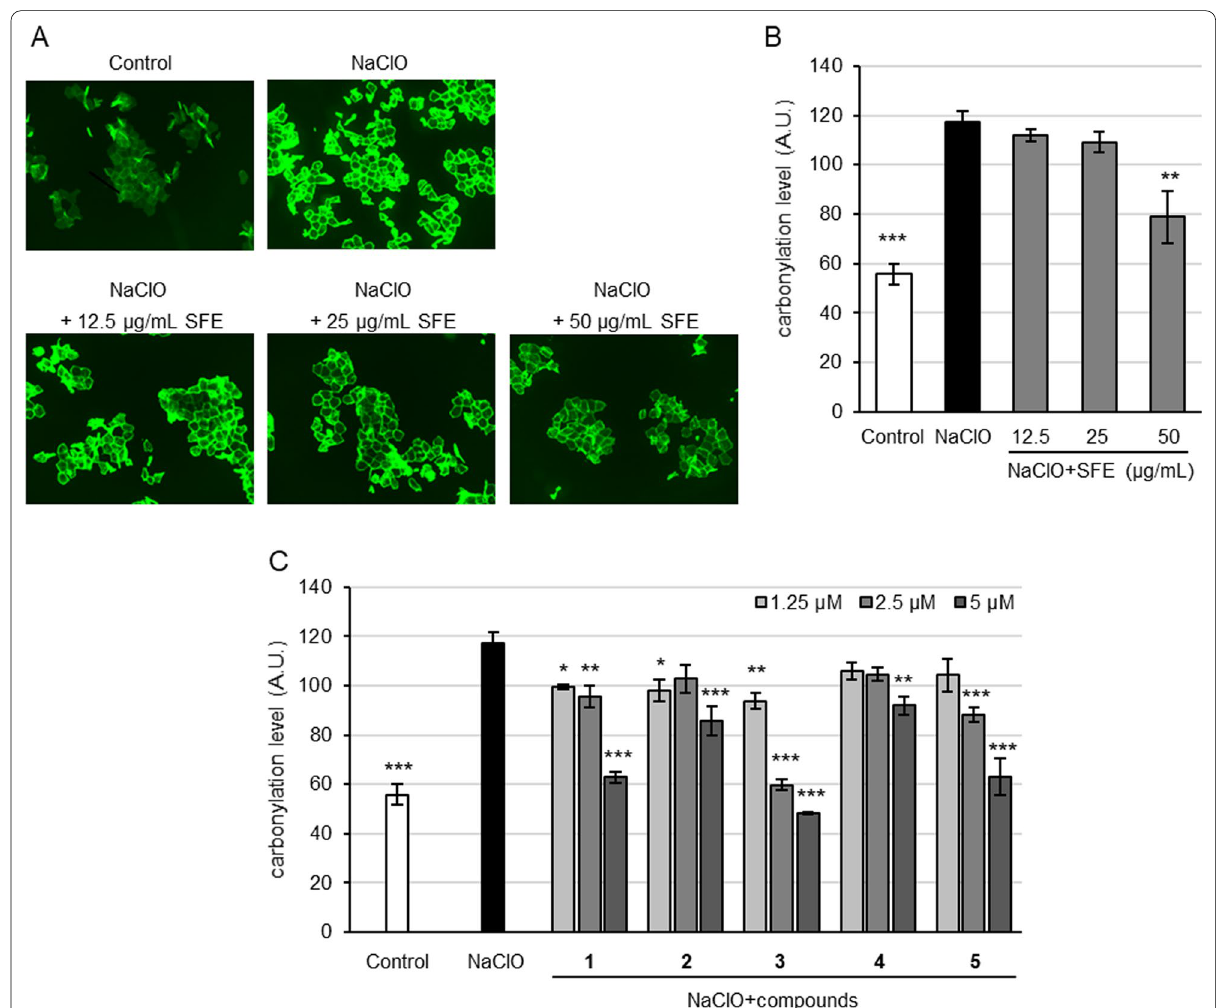
Fig. 2 Inhibitory activity of SFE and compounds 1 – 5 against NaClO‑induced protein carbonylation in SC. Tape‑stripped SC was treated with SFE or components in the absence or presence of NaClO for 16 h at 37 °C. Protein carbonylation in SC were detected by 5‑FTSC. Inhibitory activity of SFE ( A , B ) and compounds 1 – 5 ( C ) against NaClO‑induced protein carbonylation in SC and typical fluorescence image of protein carbonylation ( A ). Bars in B and C represent mean S.E., n 3; * p < 0.05, ** p < 0.01, *** p < 0.001 vs. NaClO‑treated ± =